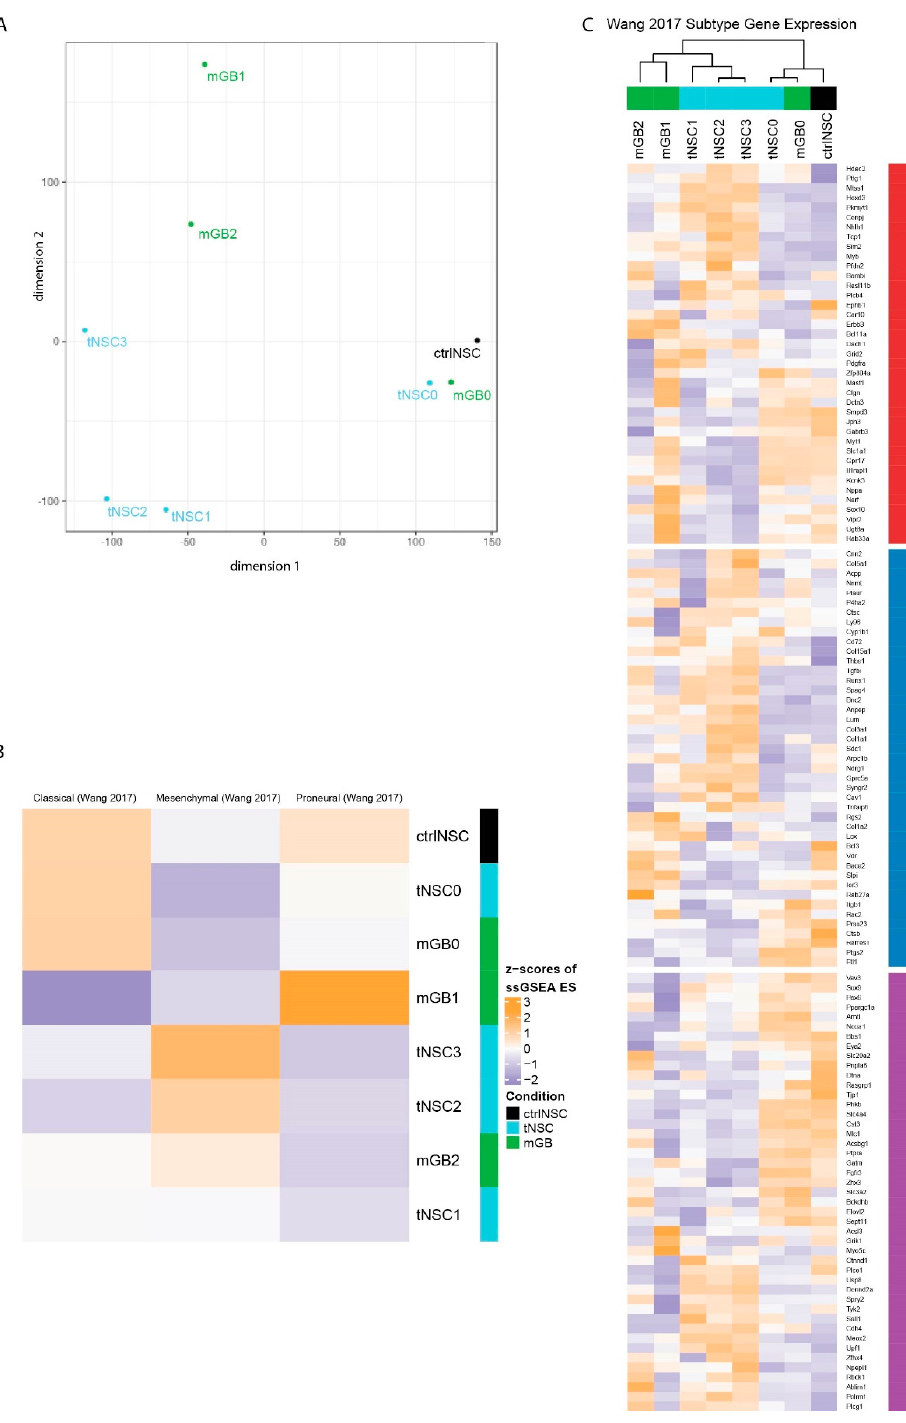
Figure 2. Transcriptomic characterization of the new glioma cell lines finds distinct expression profiles that correspond to known human glioblastoma subtypes. ( A ) Multidimensional scaling (MDS) analysis of whole transcriptomes from the newly generated glioma cell lines (tNSC0-3, mGB0-2) and of non-transformed NSCs (ctrlNSCs). ( B ) Heatmap showing z-scores of ssGSEA enrichment scores of the murine glioma cell lines for published glioblastoma subtype gene expression signatures. ( C ) Heatmap of z-scores of expression of glioblastoma subtype genes, as defined in Wang et al. Genes are labeled with their subtype. The gene expression of cell lines with sample replicates (tNSC4 and ctrlNSC: both n = 3) was averaged.